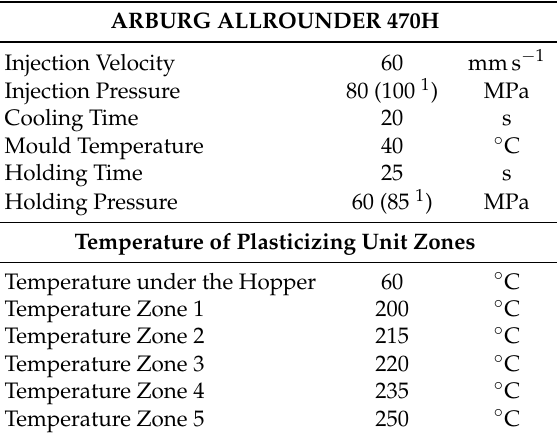
Figure 2. Test speciment. Table 1. Injection moulding processing parameters. ARBURG ALLROUNDER